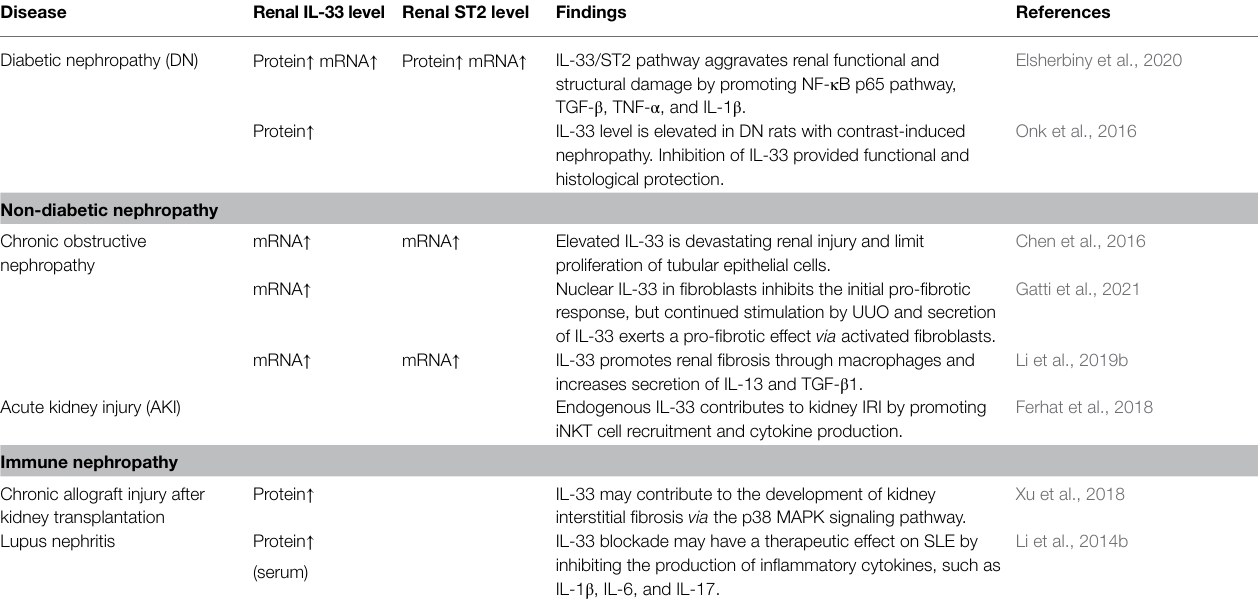
TABLE 2 | Advancements in the study of IL-33/ST2 in chronic kidney disease (CKD). Disease Renal IL-33 level Renal ST2